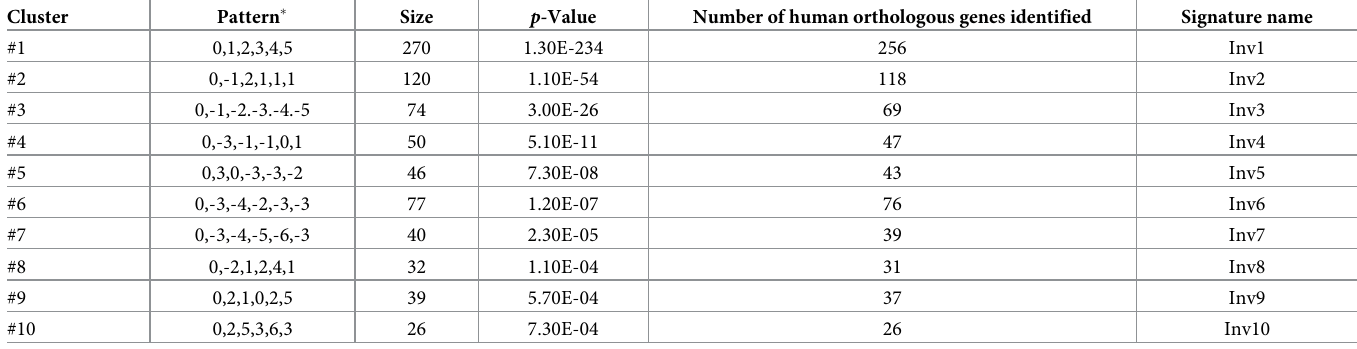
(cid:3) Pattern indicates the log2 fold change in gene expression levels of lactation day 10 and involution days 0.5, 1, 2, 3 and 4 days compared lactation day 10. Table). Ortholog data were downloaded from the ENSEMBL website and orthologous genes were identified using ENSEMBL gene id. See Table 2 for a list of the number of human ortho- logous genes identified for each of 10 significant clusters.